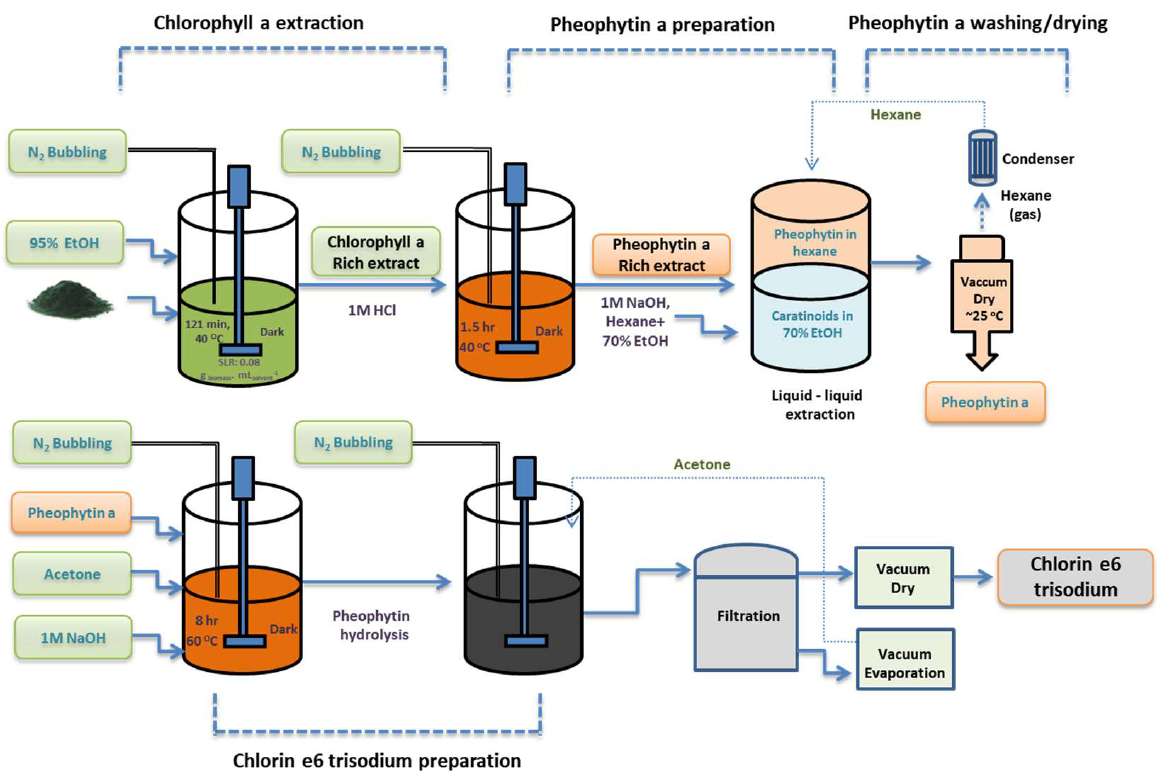
Figure 1. Process flow diagram for the extraction of chlorophyll a and synthesis of Ce6 by modified method.